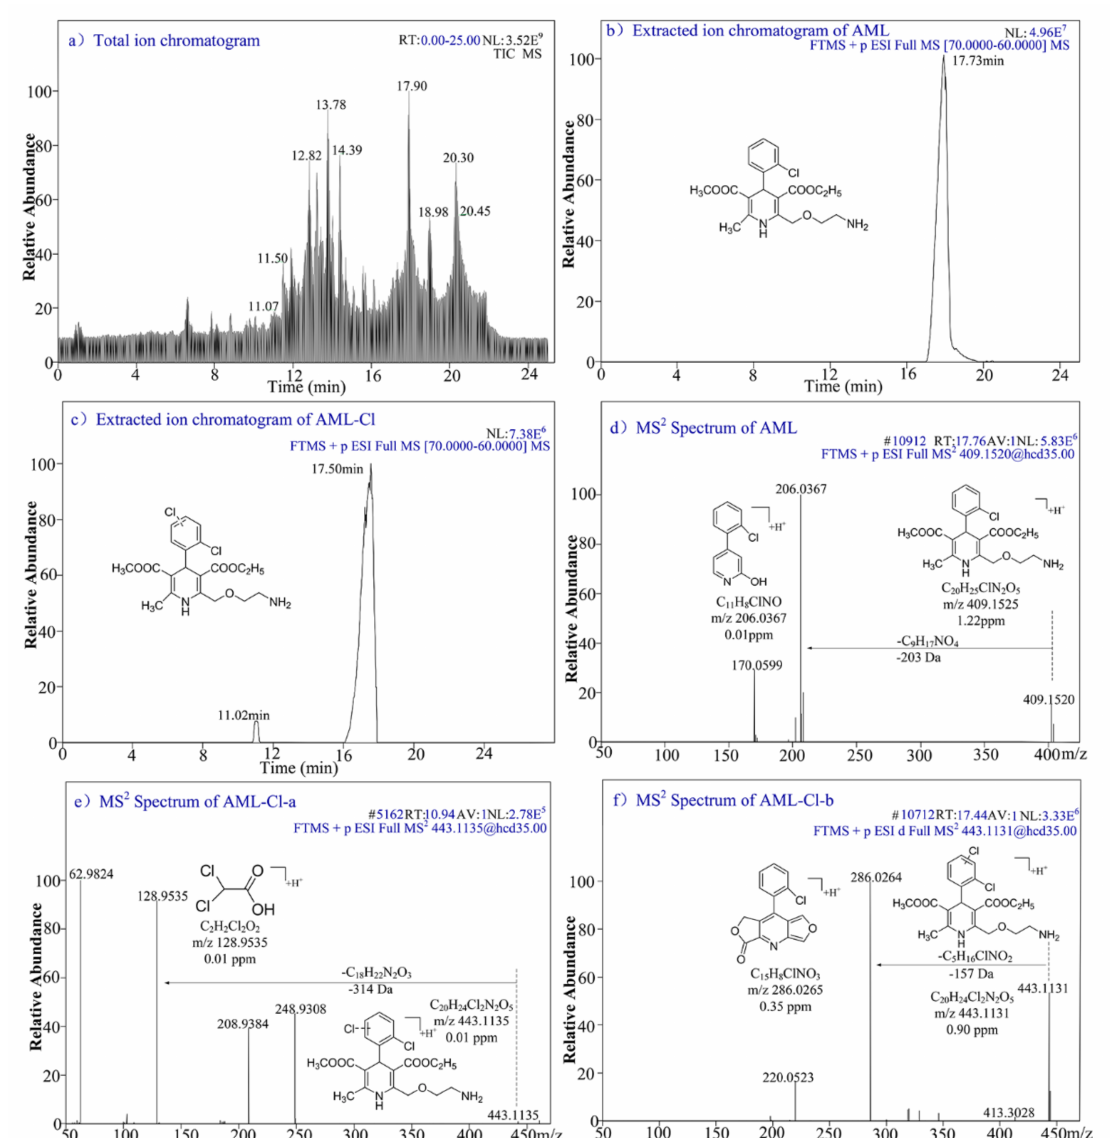
Figure 8. Total ion chromatogram (TIC), extracted ion chromatogram (EIC) and MS 2 spectra of AML and AML-Cl obtained by HRMS. ( a ) TIC spectrum, ( b ) EIC spectrum of AML at 409.1525 m / z , ( c ) EIC spectrum of AML-Cl at 443.1135 m / z , ( d ) MS 2 spectrum of AML, ( e ) MS 2 spectrum of AML-Cl-a, and ( f ) MS 2 spectrum of